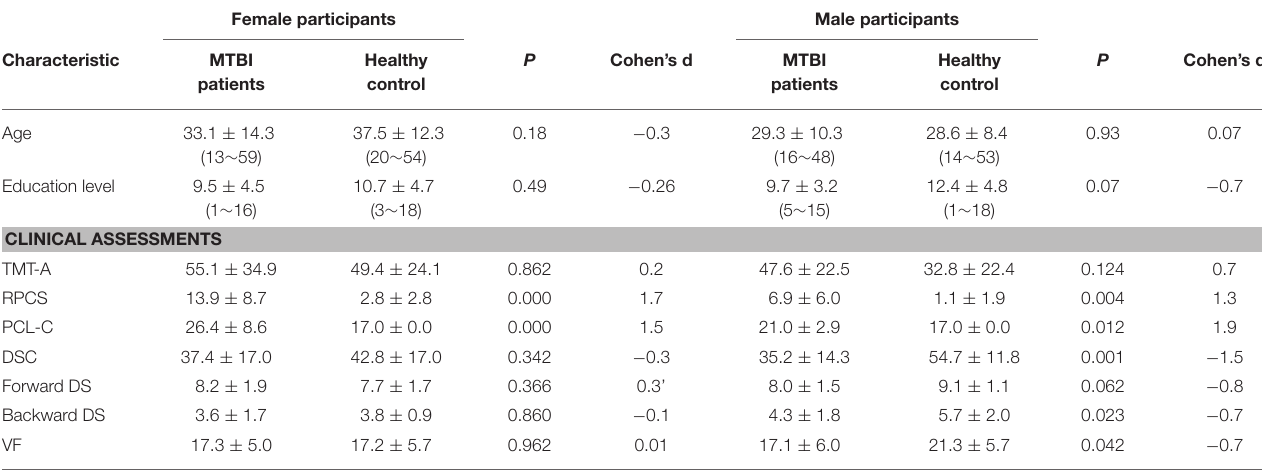
TABLE 2 | Demographic and Clinical assessments in female participants and male